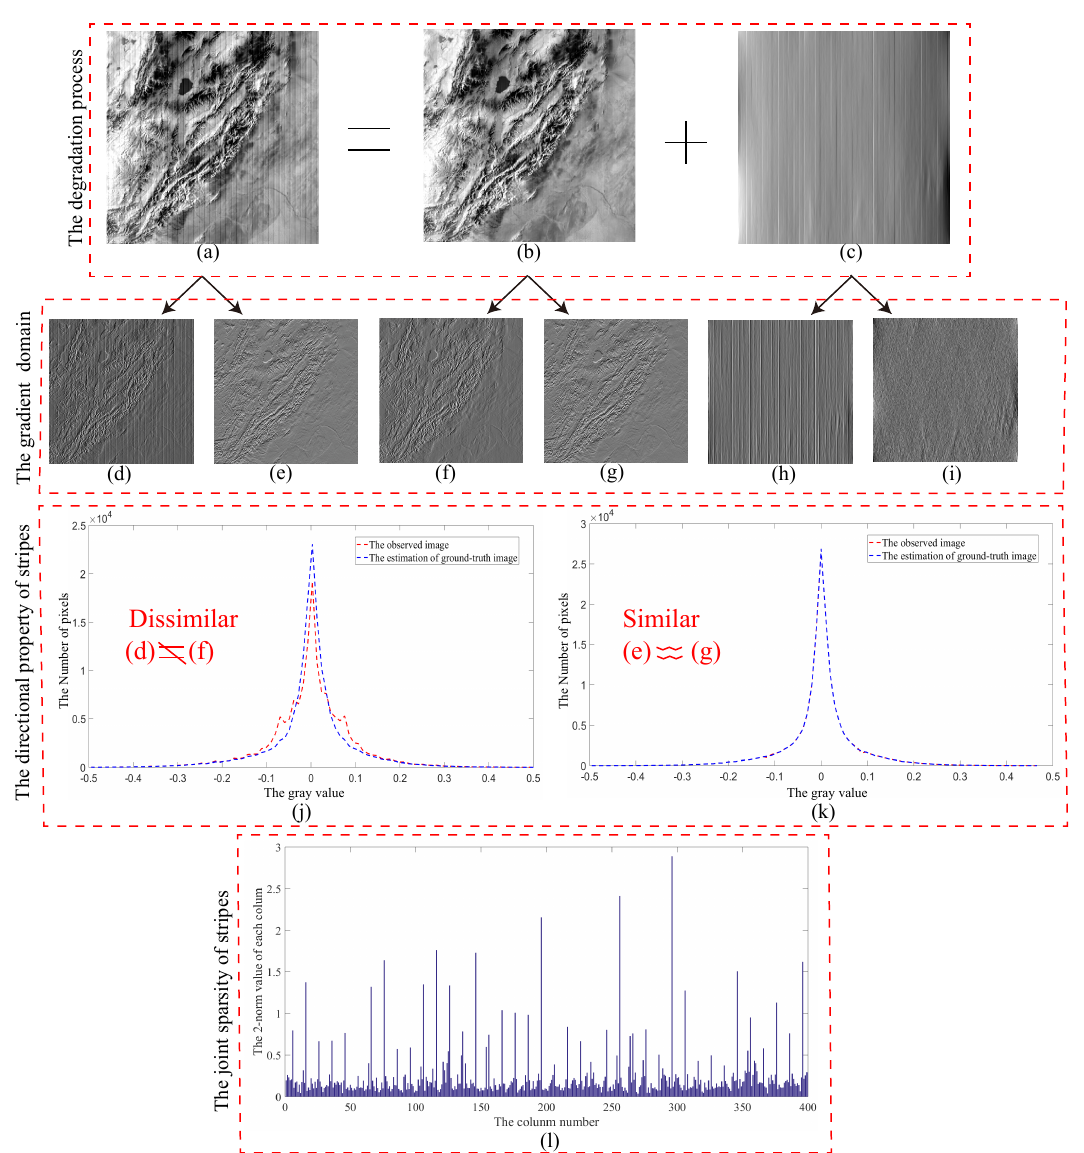
Figure 1. Destriping results in Terra MODIS by GSUTV. The first line: ( a ) Degraded image. ( b ) Destriping image. ( c ) Stripe component. The second line: ( d ) Horizontal gradient of the observed image. ( e ) Vertical gradient of the observed image. ( f ) Horizontal gradient of the destriping image. ( g ) Vertical gradient of the destriping image. ( h ) Horizontal gradient of the stripe component. ( i ) Vertical gradient of the stripe component. The third line: ( j ) Histogram of horizontal gradient. ( k ) Histogram of vertical gradient. The fourth line: ( l ) (cid:96) 2 -norm values of the stripe